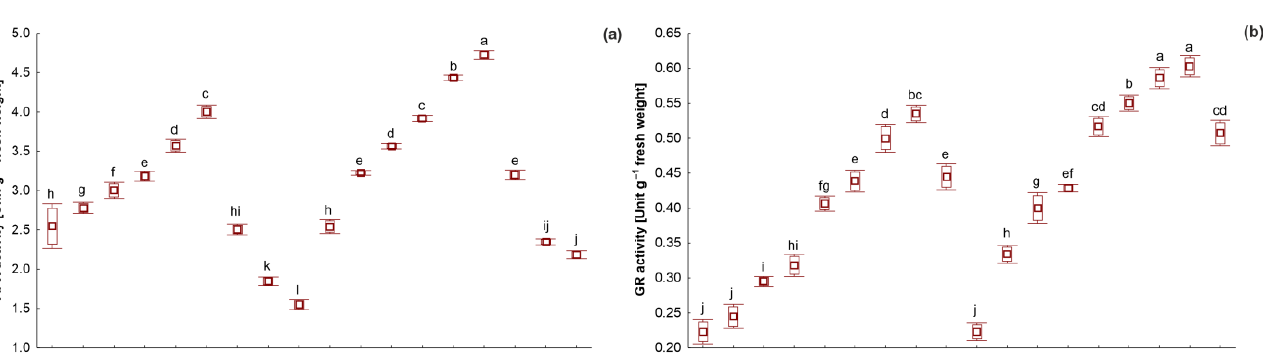
Figure 6. The activity of ascorbate peroxidase (APX) ( a ), glutathione reductase (GR) ( b ), superoxide dismutase (SOD) ( c ), and catalase (CAT) ( d ) in W. arrhiza exposed to cadmium (Cd) and/or melato- nin (MT) after 7 days of cultivation. The square represents the mean ( n = 5, biological replicate). The lower and upper hinges correspond to the lower and upper bounds of the 95% confidence interval of the means. The lower and upper whiskers extend from the hinge to the mean ± standard devia- tion. Means with the same letters are not significantly different ( p ≥ 0.05) according to Tukey’s post hoc test . 3. Discussion The toxic effect of Cd on plant growth and development is obvious. Poisoning with Cd has adverse effects on plant conditions, where exposure to Cd causes a deleterious effect on plants, inhibits growth, and decreases the content of proteins and chlorophylls, as well as enhances the level of H 2 O 2 and MDA [32,33]. Although the influence of Cd on biochemical processes was analyzed in a variety of plant species, the impact of MT is quite a new issue, especially in water plants. W. arrhiza, an aquatic plant without roots, has an absorption ability of chemical compounds from the water environment [31]. Therefore, the absorption rate of Cd ions from Hutner’s medium was notable. The present results revealed a positive correlation between the concentration of Cd added to the medium and its intracellular level in W. arrhiza cells after 7 days of cultivation. However, Cd accumu- lation decreased after 25 µM MT application, which is related to an increase in PC 2-5 . MT can also reduce the accumulation of Cd through the expression of genes responsible for the transport that leads to lower entering of Cd inside plant cells [34]. Reduced Cd uptake in W. arrhiza is probably caused by MT ’ s ability to modulate the activity of the ATP-bind- ing cassette transporter, a Cd extrusion pump [35]. Reduced intracellular Cd content un- der the influence of MT was also observed, for example, in Brassica napus seedlings [36] or roots and leaves of radish plants [34]. The foliar spray of MT also significantly decreased the accumulation of Cd in rice leaves [37]. The main aim of the present work was to determine the endogenous level of MT and its substrates in W. arrhiza treated with various concentrations of Cd ions. Since 2010,